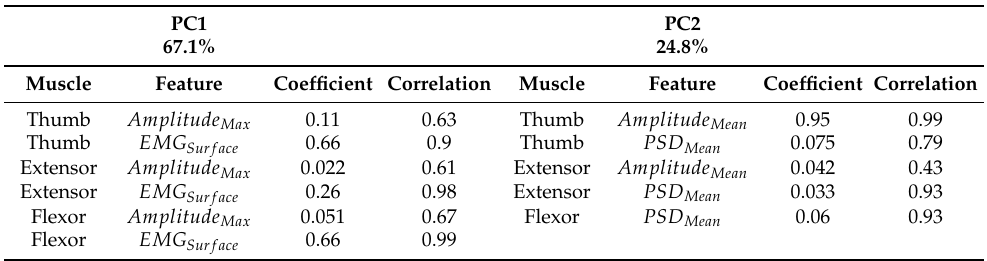
Table 6. PC coefficients and correlations between features and corresponding PC for the third scenario. Only | r | > 0.4 are shown.